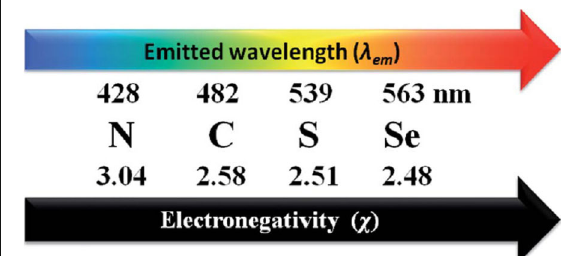
Fig. 6 The relationship between the electronegativity of heteroatoms and the emission wavelength ( λ em ) of the doped CDs